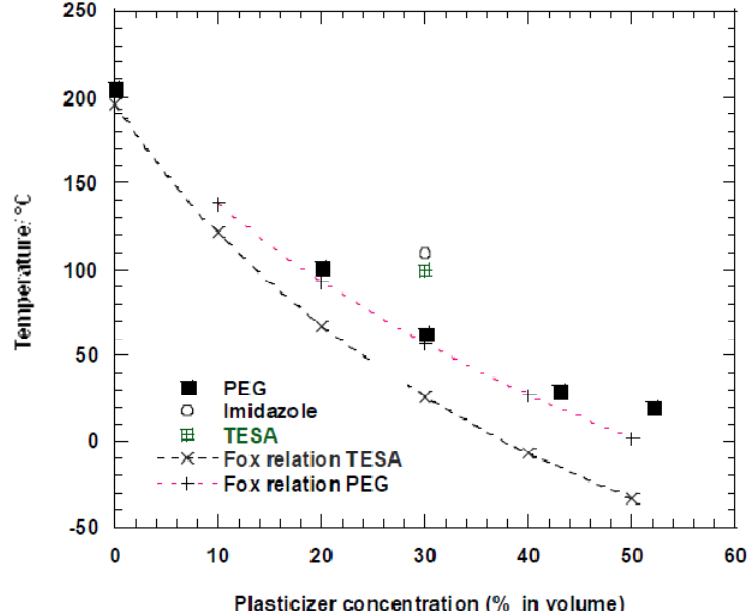
Figure 7. Tg of SPSFH (IEC = 1.35 H + /kg) blends as a function of plasticizer